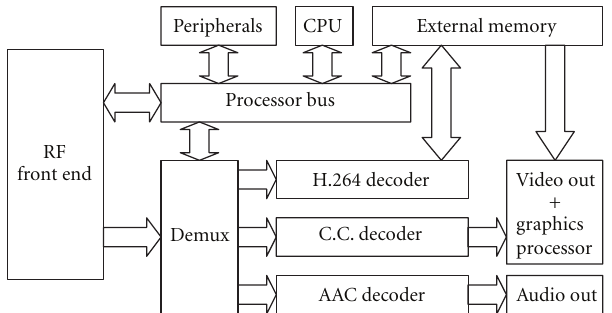
F 1: SBTVD compatible set-top